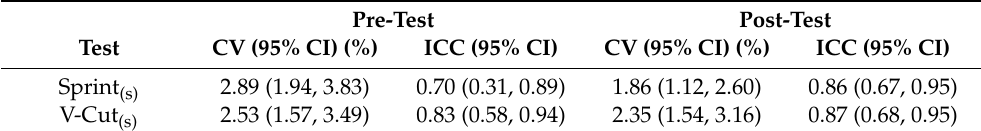
Table 12. Reliability data.